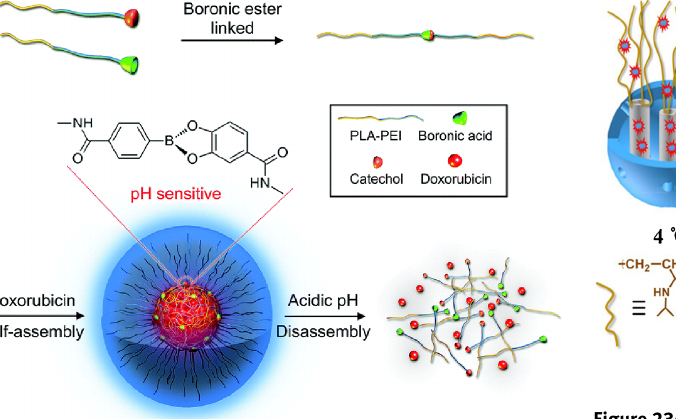
Figure 22: Schematic illustration for the formulation of FBNPs- DOX nanoparticles and pH-responsive DOX release. Reproduced with permission from [89]. Copyright 2014, The Royal Society of